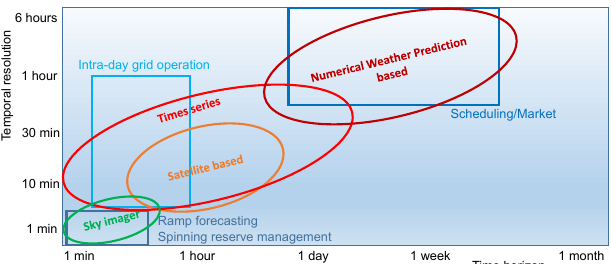
Figure 2. Forecasting time horizon versus temporal resolution according to Diagne et al.